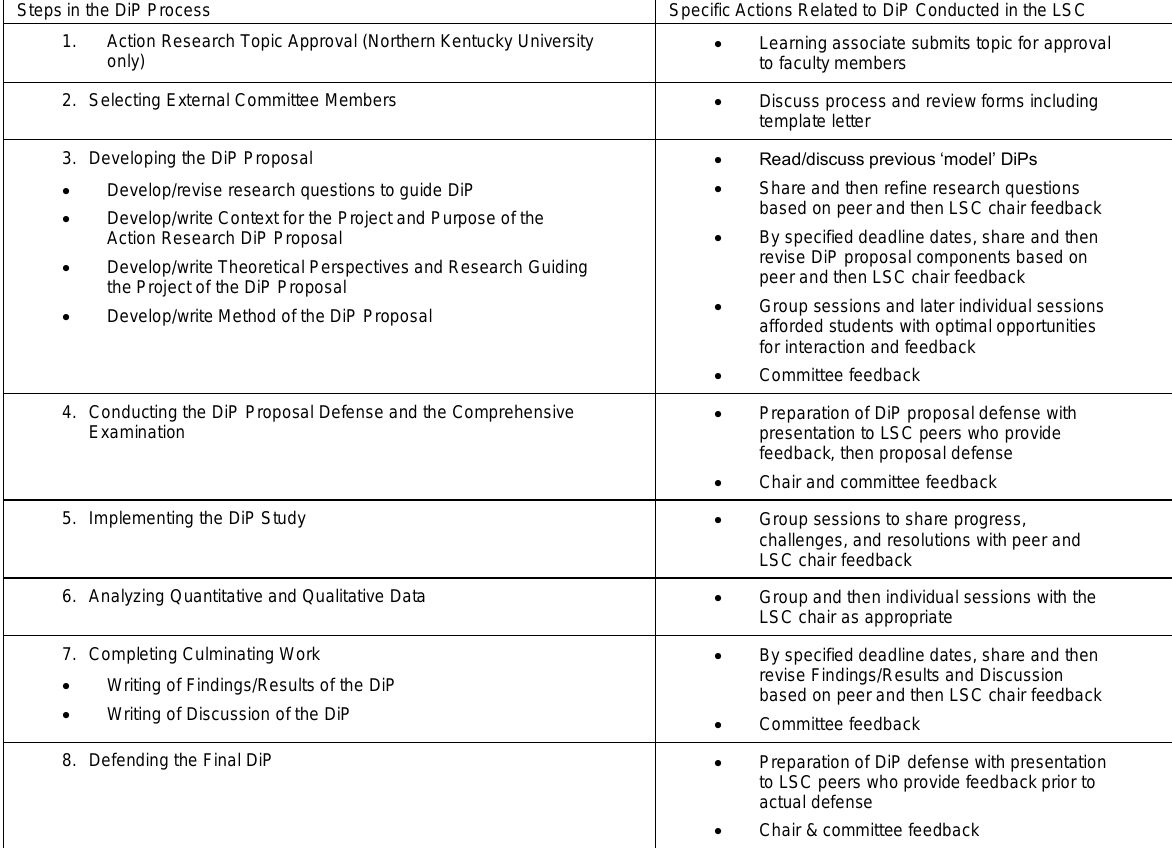
Table 1. Steps in the Dissertation in Practice and How Leader Scholar Communities Support Those Steps Steps in the DiP